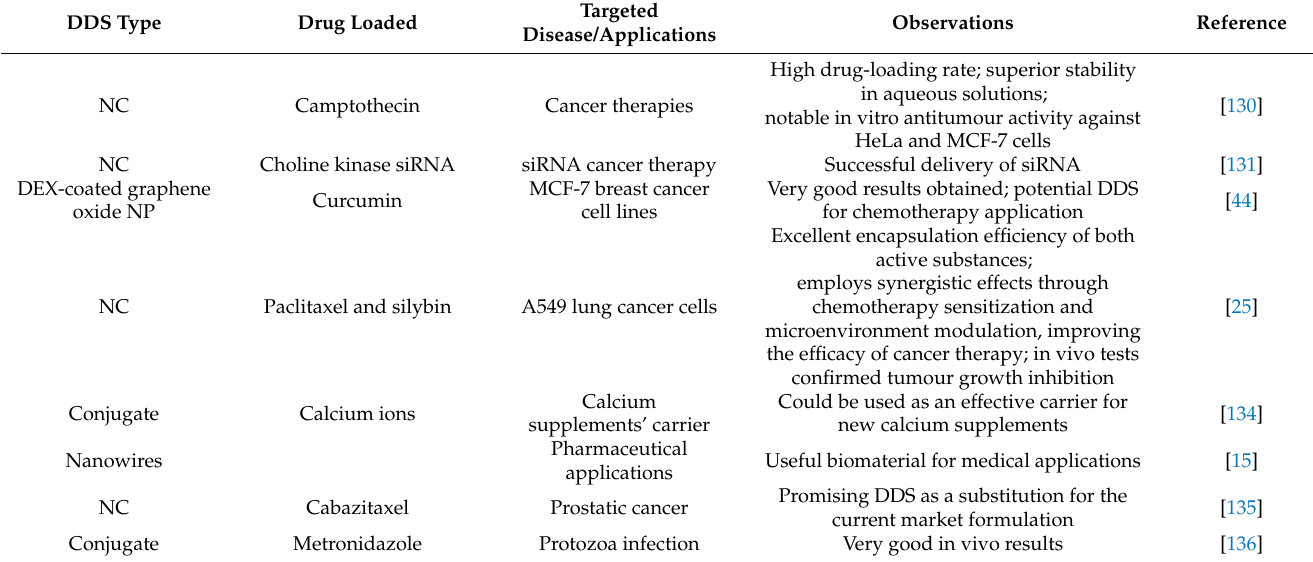
Table 4. DEX-based NCs developed for drug